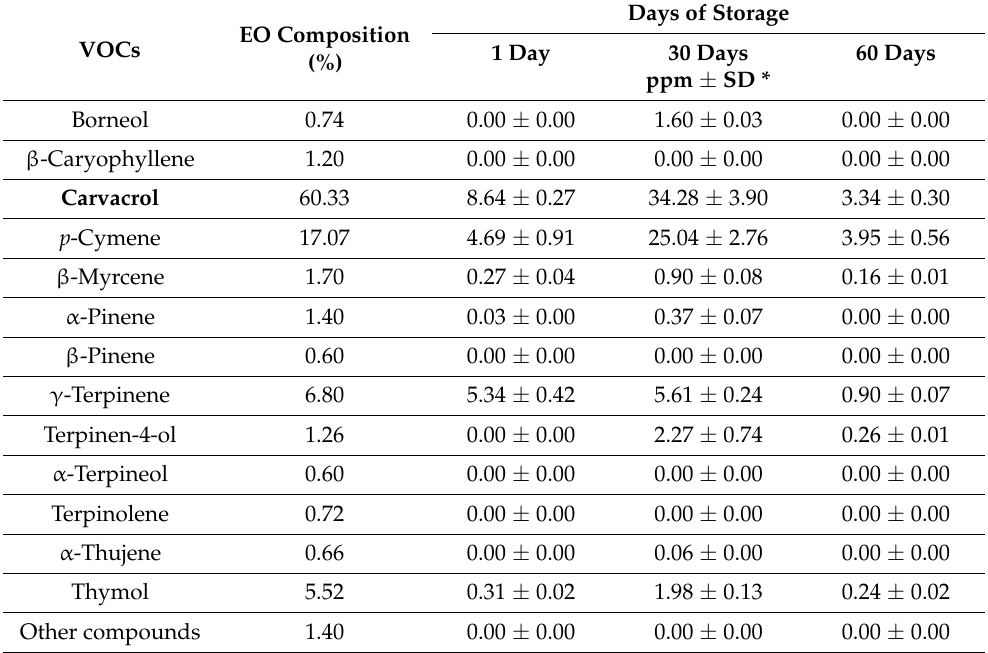
Table 5. Composition of savoury essential oil and characterization of the atmosphere of cabinet during the storage trial on apples ‘Opal’ obtained by GC-MS and SPME-GC-MS analysis, respectively. Air in the cabinet was sampled at 1, 30, and 60 days of